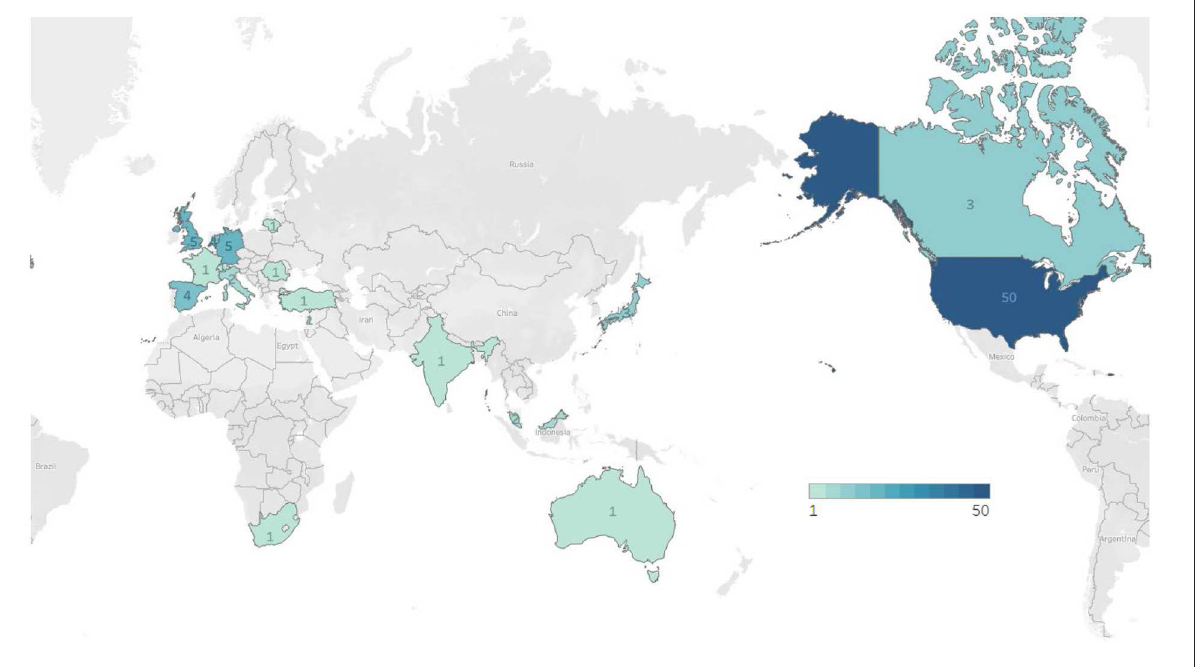
of land for a unit of produced energy from a specific energy generation source (Fthenakis and Kim, 2009). For